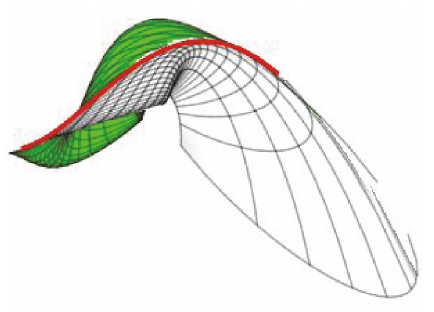
Figure 9: Projection of IS 𝛾 ± (𝑠,𝜇) (in green and in gray) and C 𝛾 (𝑠) (in red) on 𝑥 1 𝑥 3 𝑥 4 -space.